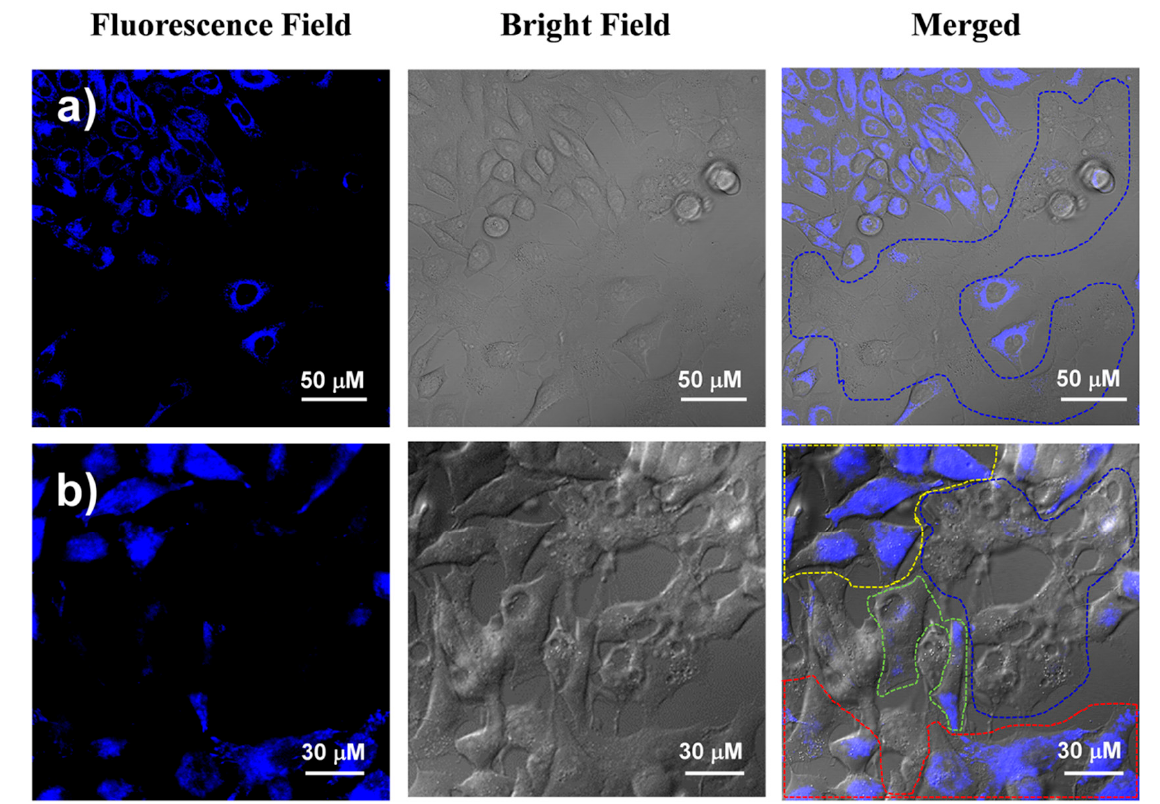
Figure 7. The CLSM images of ( a ) MCF-7 and COS-7 cells; ( b ) MCF-7, 4T1, and COS-7 cells cocultured with QICY.